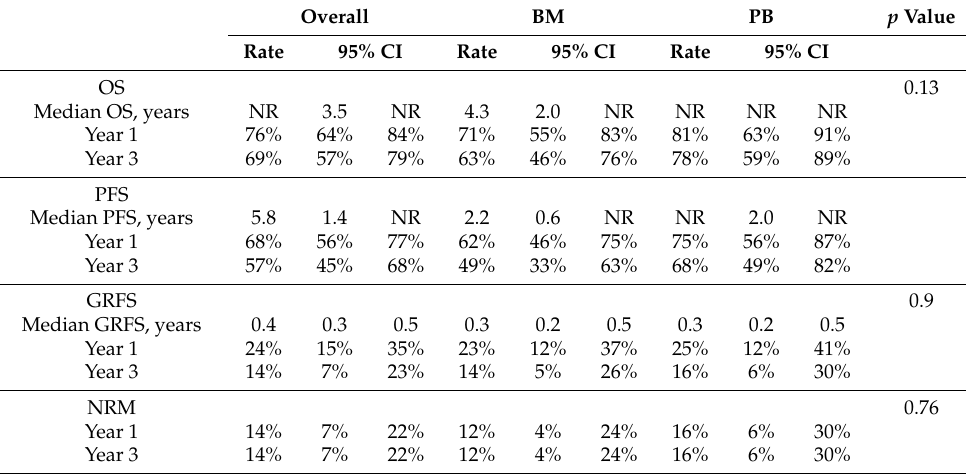
Table 3. Clinical outcomes, overall and stratified by BM and